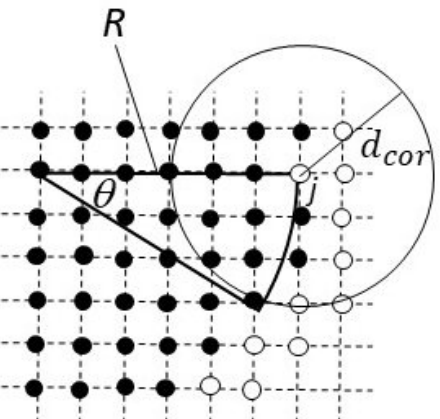
Figure 3. Schematic diagram of the distance d cor based on the arti- ficial potential calculation for a two-dimensional case. Open circles represent surface points for the potential field calculation, and solid circles indicate points occupied by material. To discriminate the cur- vature of the radius R from the calculated potential at surface point j , the length d in Eq. (2) should be larger than d cor . A spherical mixed particle is automatically generated from the potential calcu- lations and adding water-soluble material when the soot particle is completely